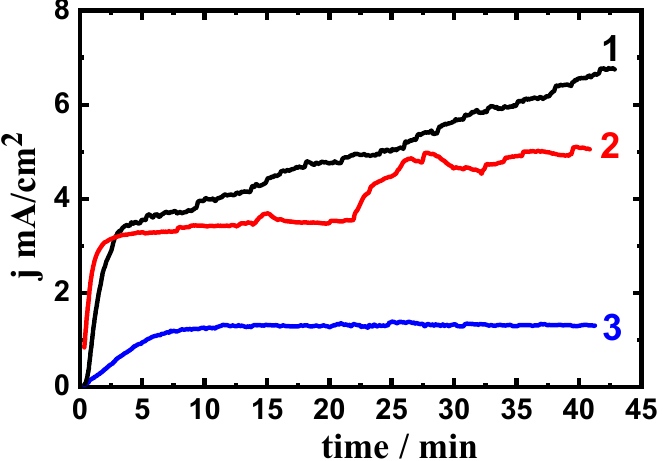
Figure 11. PCT curves obtained at − 500 mV for (1) first Al-SiC nanocomposite, (2) second Al-SiC nanocomposite and (3) third Al-SiC nanocomposite after their immersion in 3.5% NaCl solutions for 24 h.